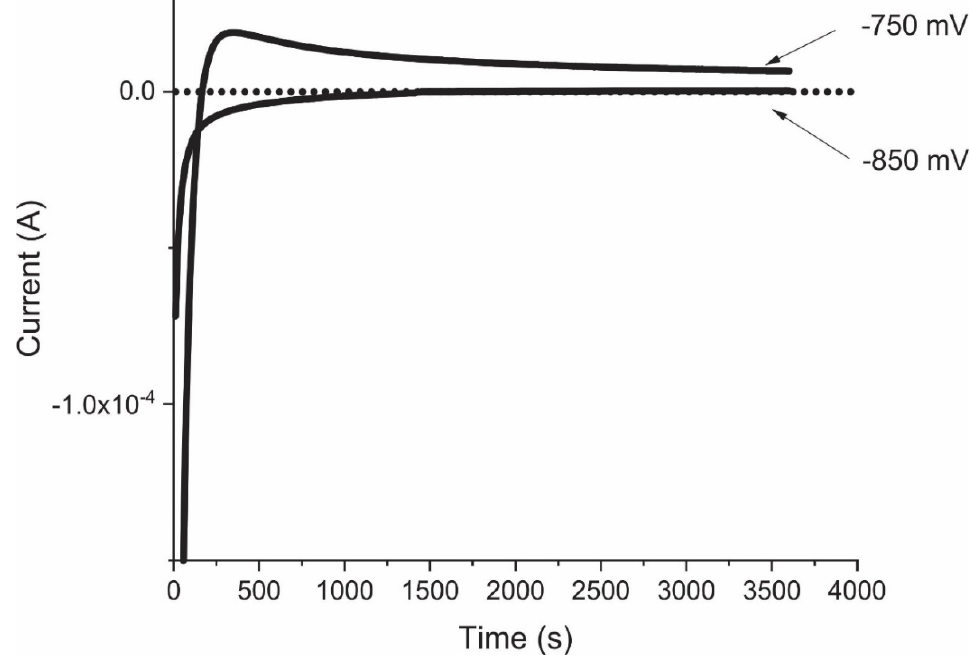
Figure 2. Chronoamperometry readings at − 750 mV Ag/AgCl and − 850 mV Ag/AgCl .